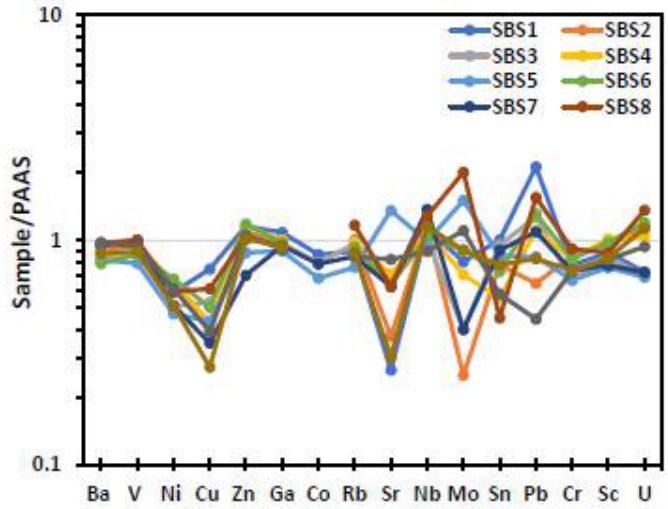
Figure 6. Trace elements in black mudstones normalized to PAAS.